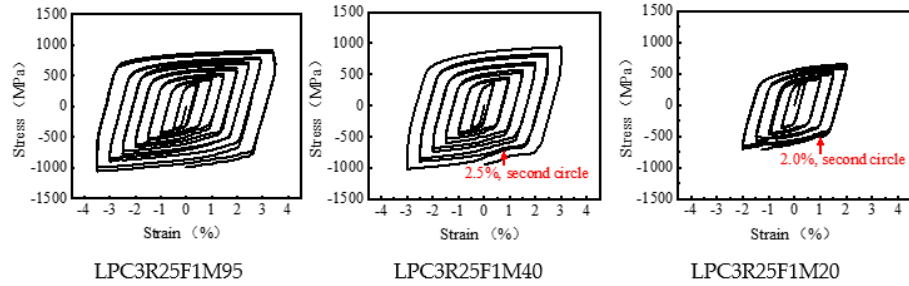
Figure 10. Hysteretic response curves of the proposed LPBRBs.